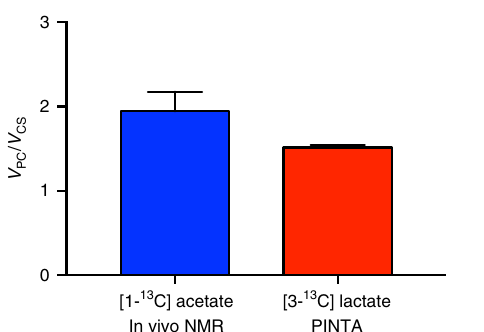
Fig. 3 V PC / V CS ratios in healthy human control subjects. The measured ratios are comparable as measured by in vivo NMR at 4 T or by PINTA. Data are presented as the mean ± S.E.M. of n = 3